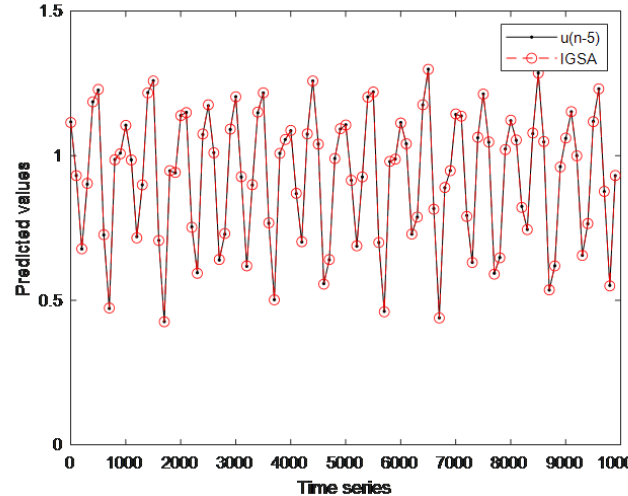
Figure 16. Predicted values for the MG time